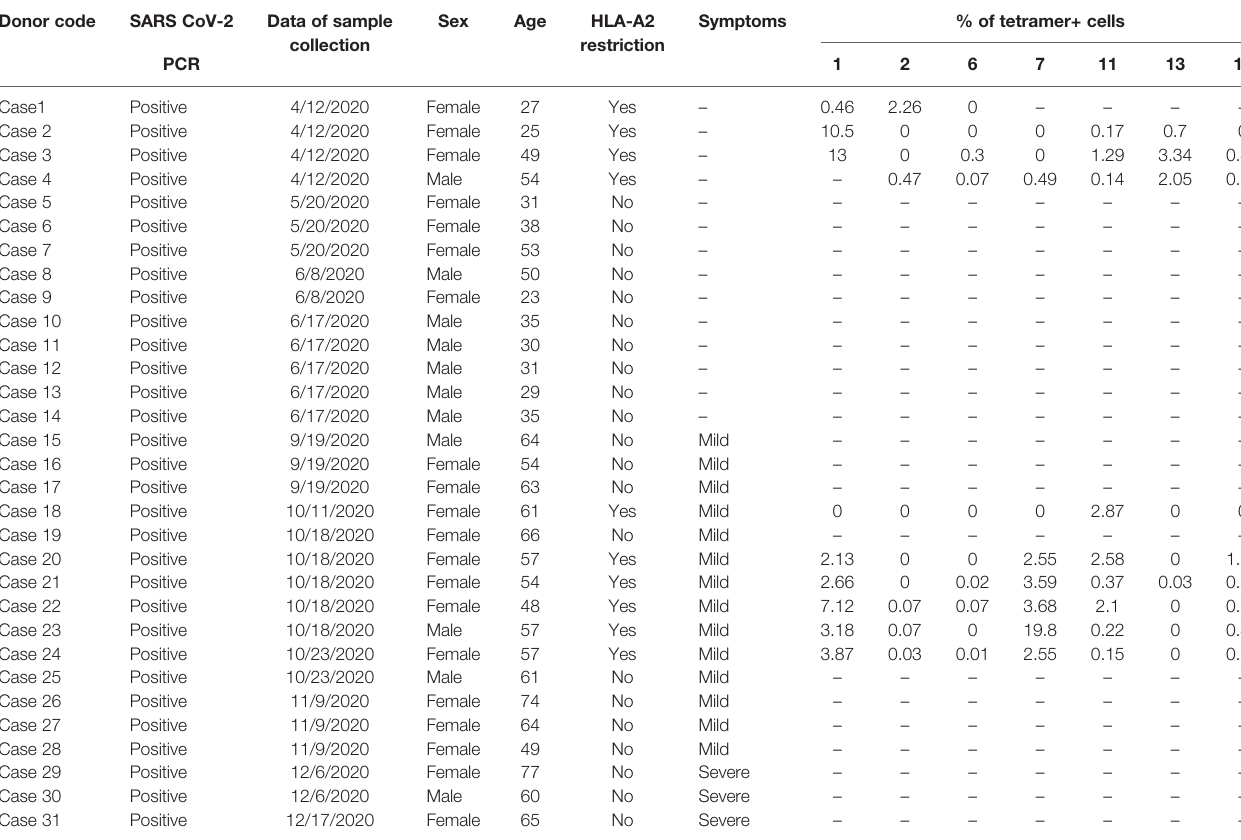
TABLE 2 | Clinical characteristics of 31 convalescent COVID-19